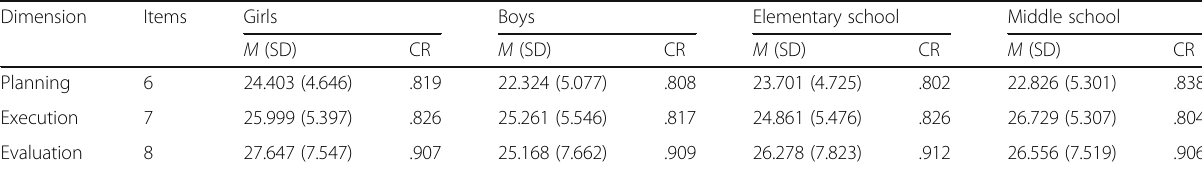
Table 3 Descriptive statistics and reliability coefficients Dimension